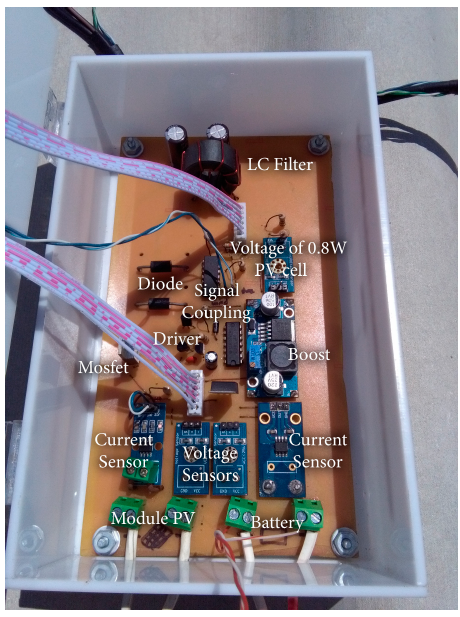
Figure 18. Buck converter and sensors used.